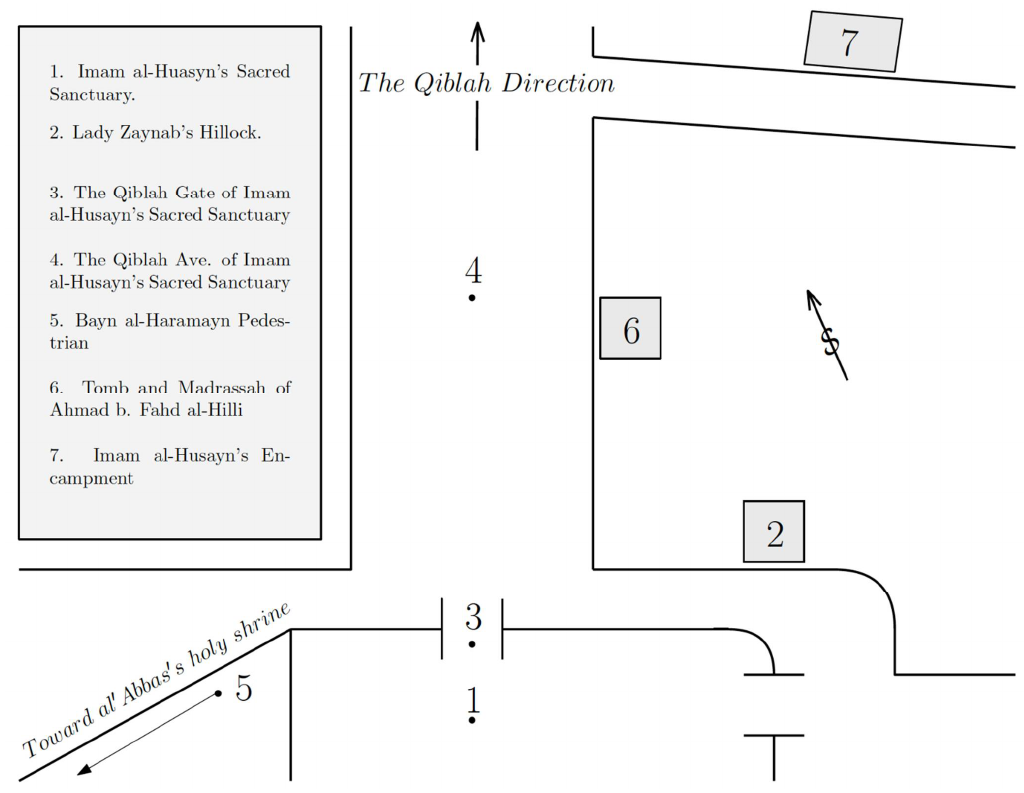
Figure 13. Imam al-Husayn’s Sacred Sanctuary and its Associated Pilgrimage sites at Karbala. Source: Original graphic rendered from sketch provided by Muhammad-Reza Fakhr-Rohani, 2021.